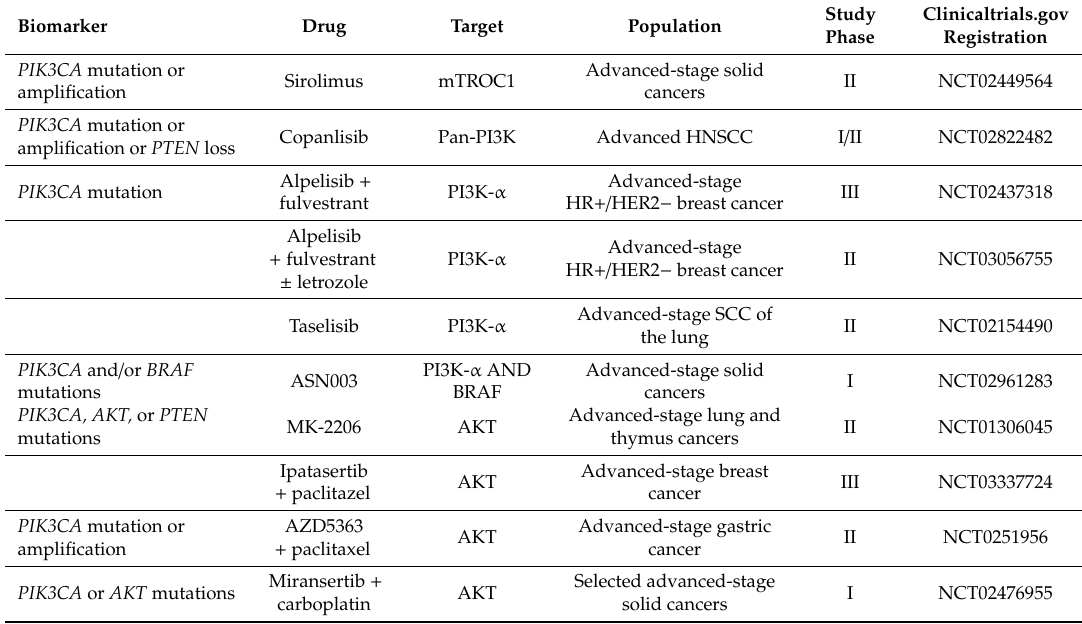
Table 3. Clinical trials that lead to mTOR and PI3K inhibitors in solid and hematological tumors. Biomarker